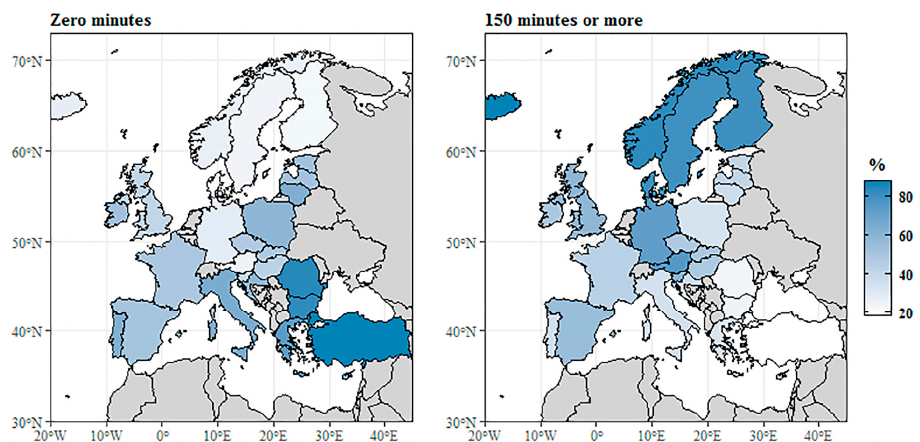
Figure 1. Time spent on health-enhancing (not work-related) aerobic physical activity (2014). Source: [136].